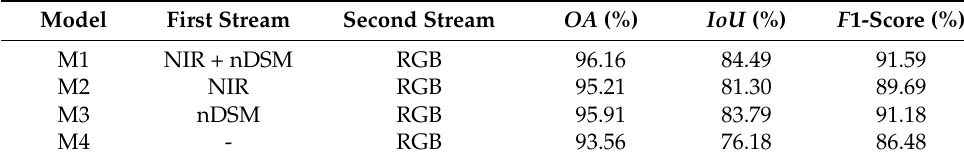
Table 3. Accuracy of building extraction based on different modal data